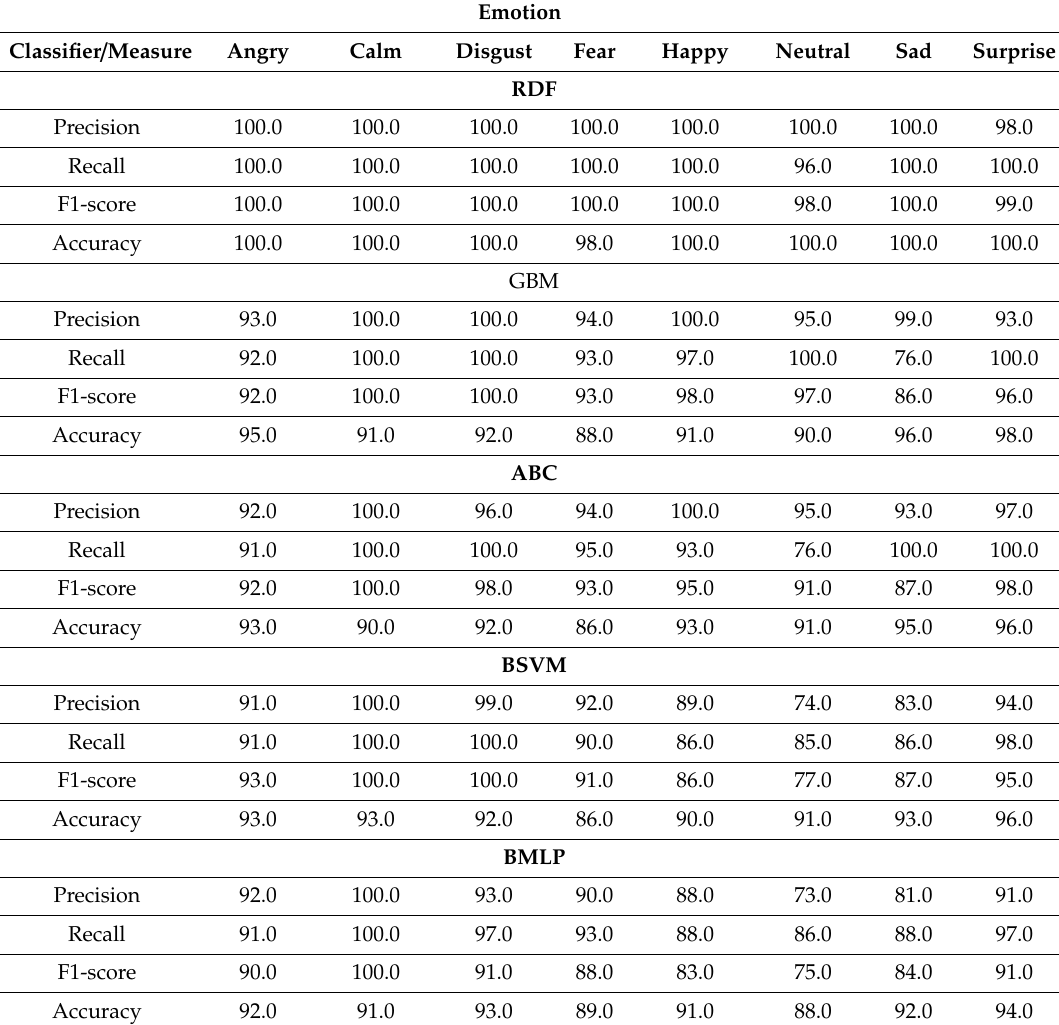
Table 7. Percentage precision, recall and F1-score and accuracy on RAVDESS